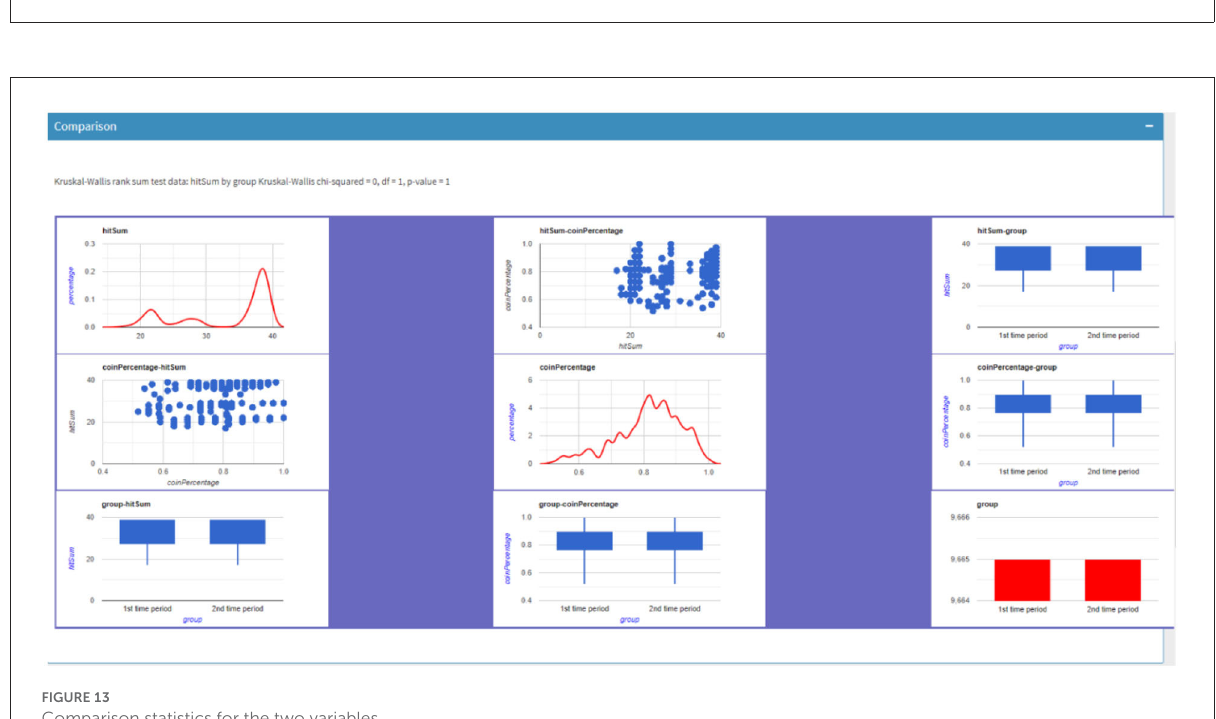
FIGURE13 Comparison statistics for the two